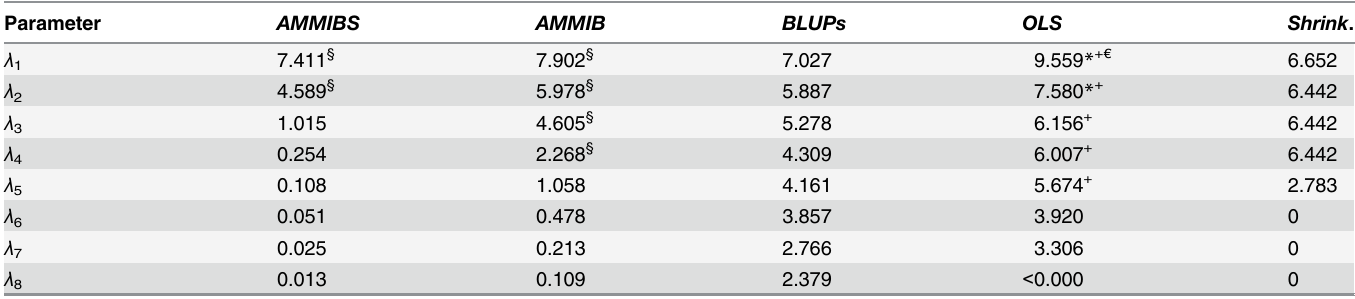
* Signi fi cant by the Cornelius F-test at a 0.05 signi fi cance level + Signi fi cant by the Gollob F-test at a 0.05 signi fi cance level. € Number of terms retained on the AMMI model based on leave-one-out cross validation using W's score by Dias and Krzanowski. § Model selection based on Bayes